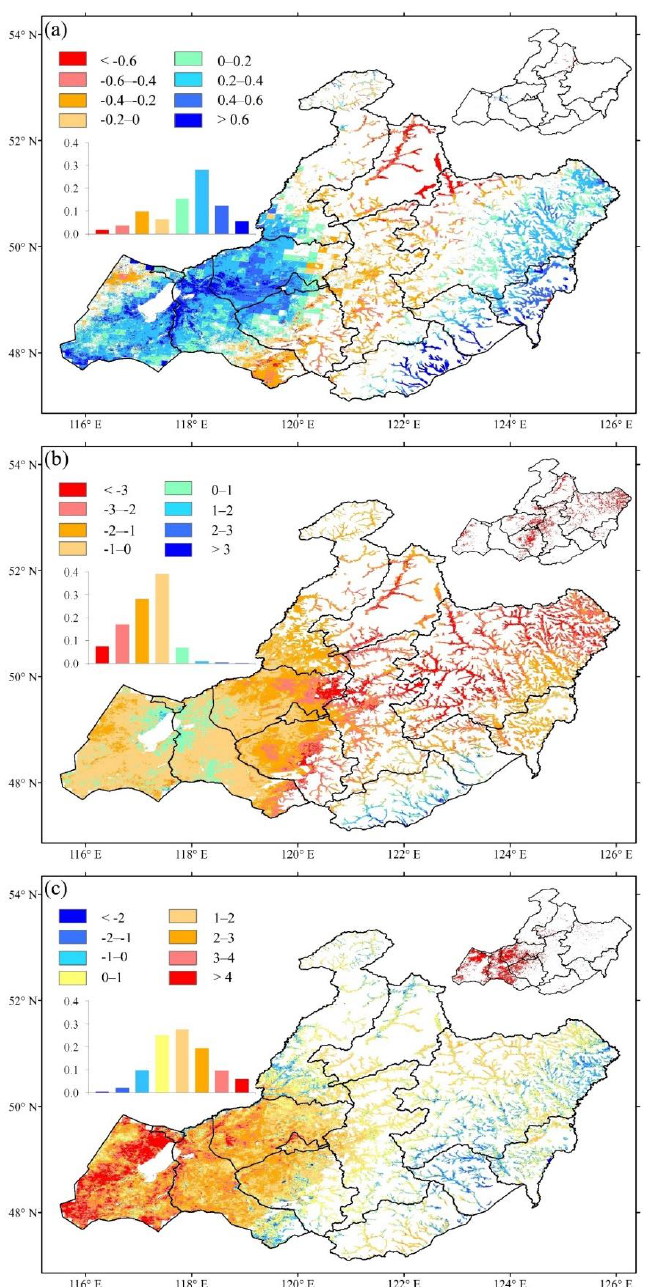
Figure 11. Spatial pattern of the temporal trends in ( a ) chilling days in days year −1 , ( b ) precipitation in mm year −1 , and ( c ) insolation in W m –2 year –1 . The top-right insets indicate pixels with a significant ( p < 0.05) increase (blue in ( a ) and ( b ) and red in ( c )) or decrease (red in ( a ) and ( b ) and blue in ( c )). The middle-left insets show the frequency distributions of trends corresponding to the values indicated by the map legends.